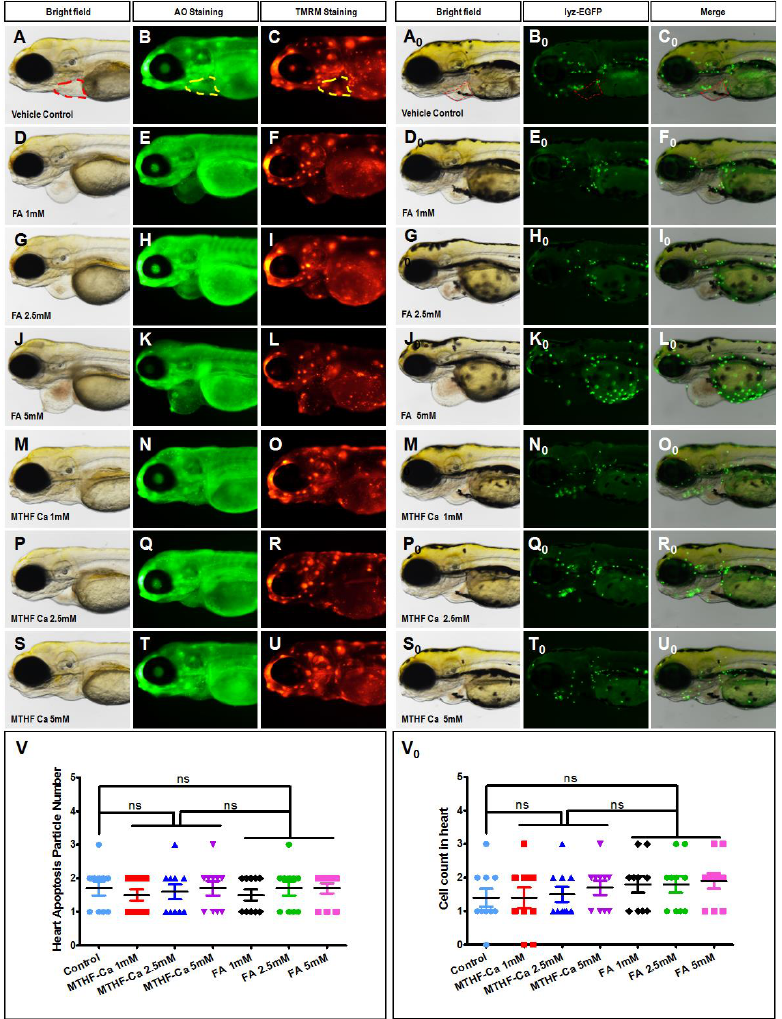
Figure 3. FA and MTHF-Ca do not induce heart-specific apoptosis and macrophage migration. ( A – U ) Representative bright-field and fluorescent images at 4 dpf treated with vehicle control (fish water), FA (1 mM, 2.5 mM, and 5 mM), or MTHF-Ca (1 mM, 2.5 mM, and 5 mM). Vehicle-control embryos and FA- or MTHF-Ca-treated embryos were stained with acridine orange (AO) at 4 dpf. The mitochondrial membrane potential ( ∆Ψ m) was estimated by monitoring fluorescence aggregates of TMRM (tetramethyl rhodamine methyl ester, perchlorate, and biotium). FA and MTHF-Ca do not induce heart-specific mitochondrial defects. Heart apoptotic cells are visible as bright green spots, and less-bright homogenous green staining is unspecific background staining. Both FA- and MTHF- Ca-treated embryos exhibited few or no apoptotic cells in the heart. (Figure S2). ( V ) Quantification of apoptosis particle number in the heart. Error bars: SEM; ( n = 10; ANOVA; ns: not significant). ( A – L ) Lateral view, anterior, left. ( A 0 – U 0 ) Representative bright-field and fluorescent images of TG (zlyz:EGFP) larvae at 4 dpf (dpf) treated with vehicle control (fish water), FA (1 mM, 2.5 mM, and 5 mM), or MTHF-Ca (1 mM, 2.5 mM, and 5 mM). Control fish showed the normal distribution of labeled cells (( A 0 – C 0 ), circle area). Compared with vehicle-control fish, FA- or MTHF-Ca-treated fish also showed the normal distribution of labeled cells. (Figure S3). ( V 0 ) Quantification of the macrophage number in the heart. Columns: means; bars: SEM ( n = 10; ANOVA). FA: folic acid; MTHF-Ca: 6S-5-methyltetrahydrofolate-calcium. ns: not